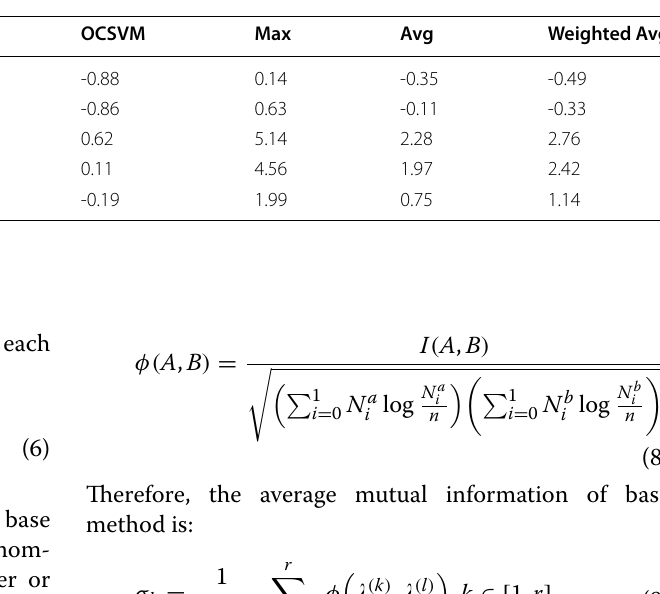
Table 5 Linear ensemble methods example: on the left side is anomaly scores obtained by each base method; on the right side is anomaly scores obtained through ensemble